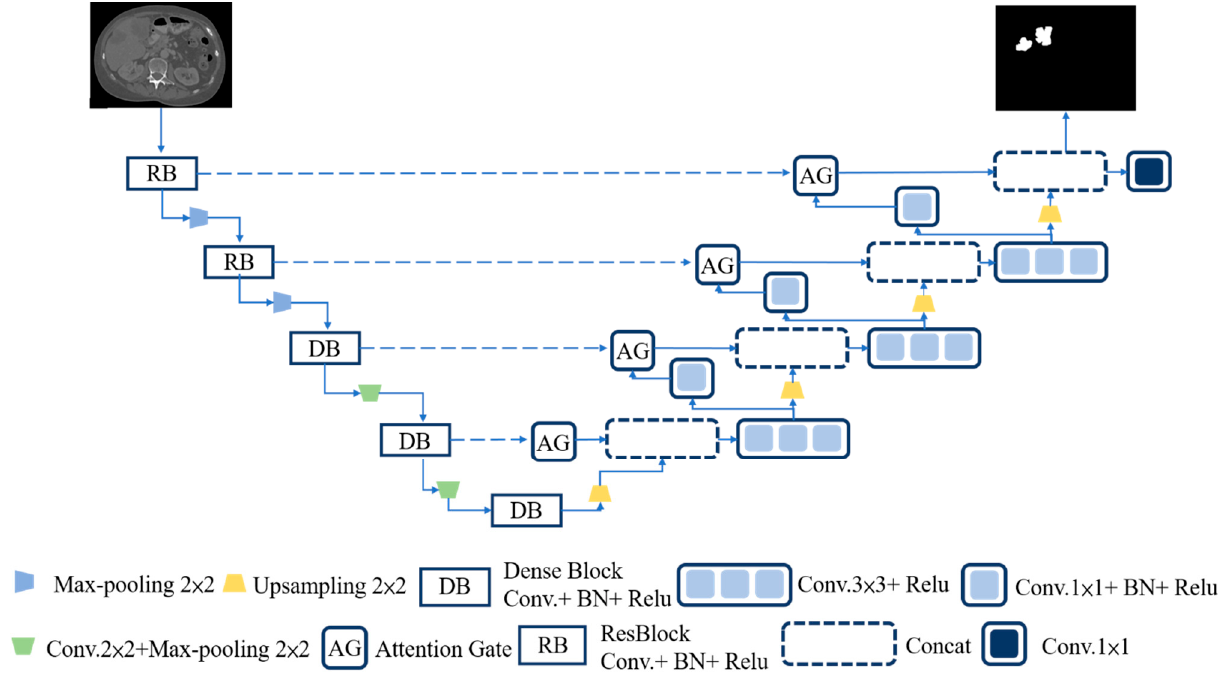
Figure 2. Designed model framework.